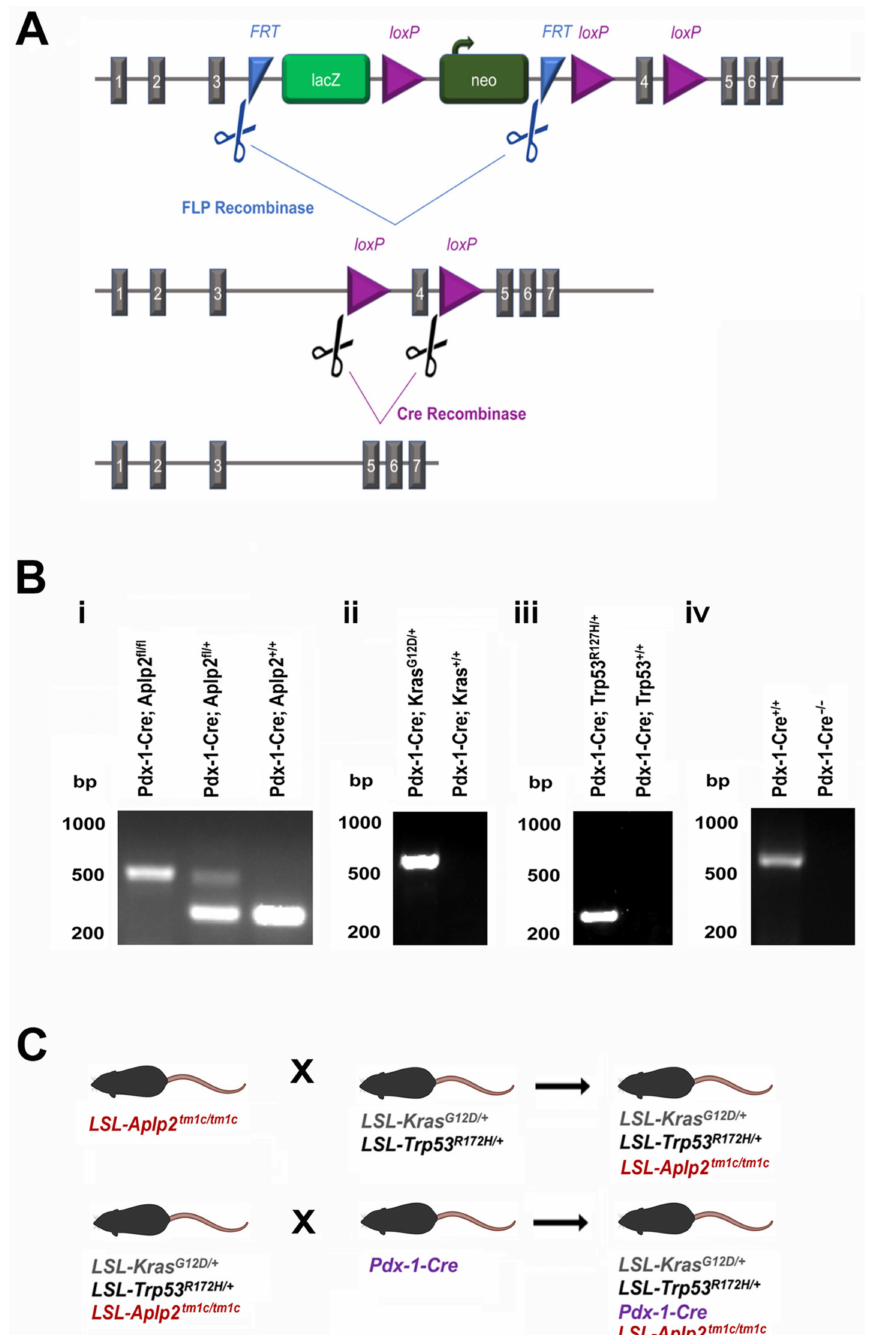
Figure 5. Generation of KPC variants with APLP2 deficiency in the pancreas. ( A ) The initially engineered mouse Aplp2 construct (called tm1a ) has FRT sites (blue triangles) flanking the lacZ/neo promoter cassette. Crossing mice expressing tm1a ( Aplp2 tm1a/tm1a ) with Flp recombinase-expressing mice ( FLPo10 ) produced mice expressing the tm1c construct, which lacks the lacZ/neo promoter cassette that had been flanked by FRT sites and which has a loxP -flanked fourth exon (thus, mice expressing tm1c are also referred to in this report as floxed LSL-Aplp2 mice). Subsequent breeding with Cre recombinase-expressing mice ( Pdx-1-Cre ) removed the fourth exon of the Aplp2 gene. ( B ) The mice strains were genotyped by PCR. ( i ) Co-expression of Pdx-1-Cre with Aplp2 fl/fl , Aplp2 fl/ + , or Aplp2 +/+ results in differential PCR products. ( ii, iii, iv ) PCR amplification of conditional mutant (floxed) alleles resulted in a PCR product of ~600 bp for LSL-Kras G12D/+ and ~250 bp for LSL-Trp53 R172H/+ . For Pdx-1-Cre , the genotyping PCR amplification resulted in a product of ~600 bp. ( C ) The stepwise mouse breeding strategy is